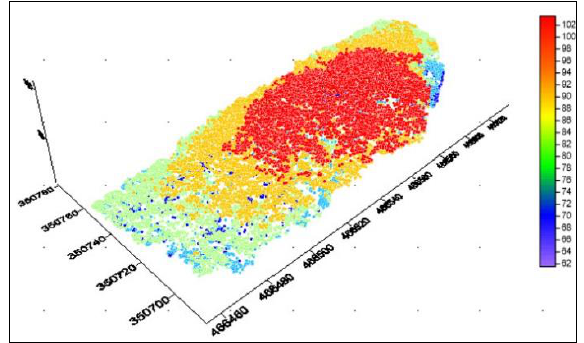
Figure 4. Raw airborne LiDAR data for rubber trees vegetation